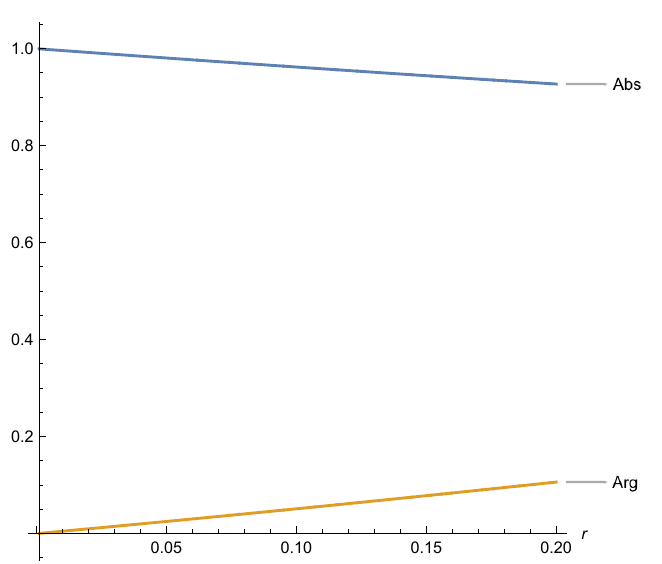
= re 2 π i with r = | 1 | . 3 2 δ 2 δ